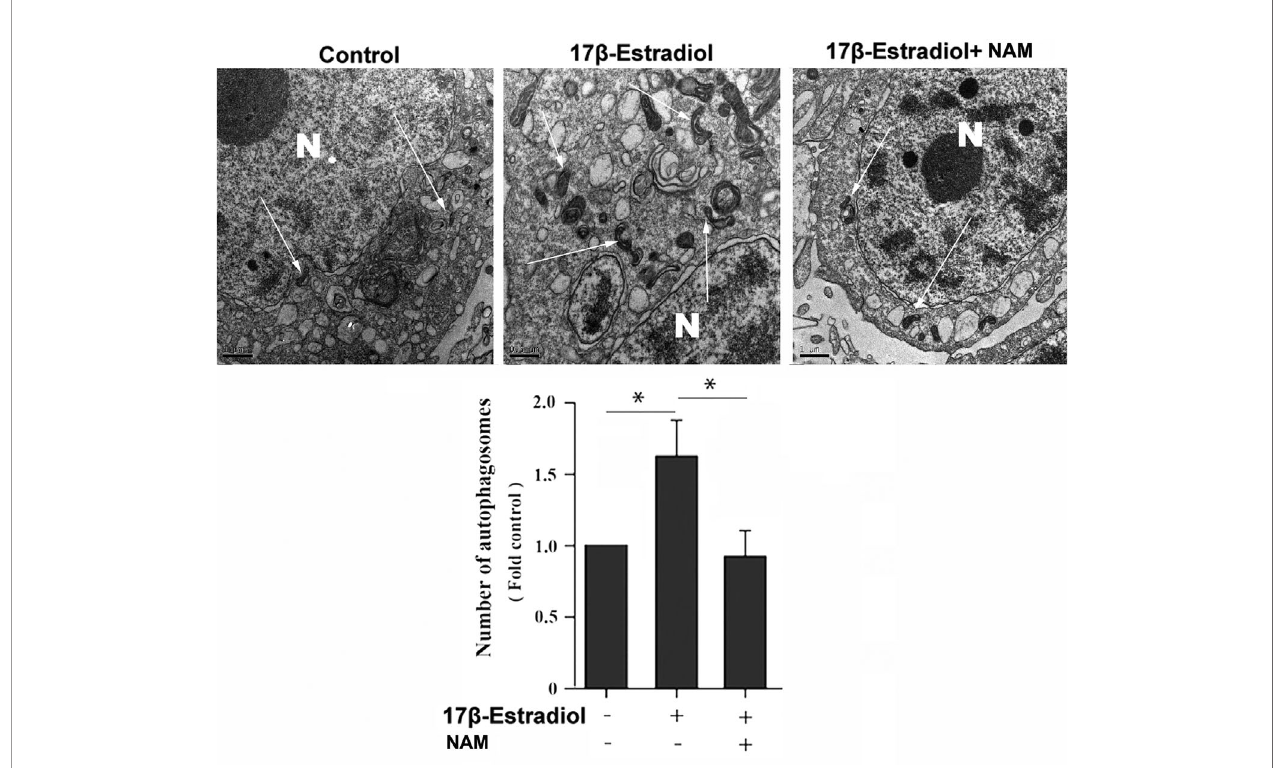
FIGURE 3 | Effect of SIRT1-mediated 17 b -E2-induced mitophagy in ATDC5 chondrocytes. Transmission electron microscope (TEM) images indicated more mitophagomes (double-membrane vacuoles) in ATDC5 cells pretreated with 1 × 10 -7 M 17 b -E2 for 24 h compared with those in the control group and 17 b -E2 + NAM group. White arrows indicate the mitophagomes (autophagic vacuoles), and the nucleus is represented by the N of ATDC5 chondrocytes. * P < 0.05 versus the control group indicated a signi fi cant